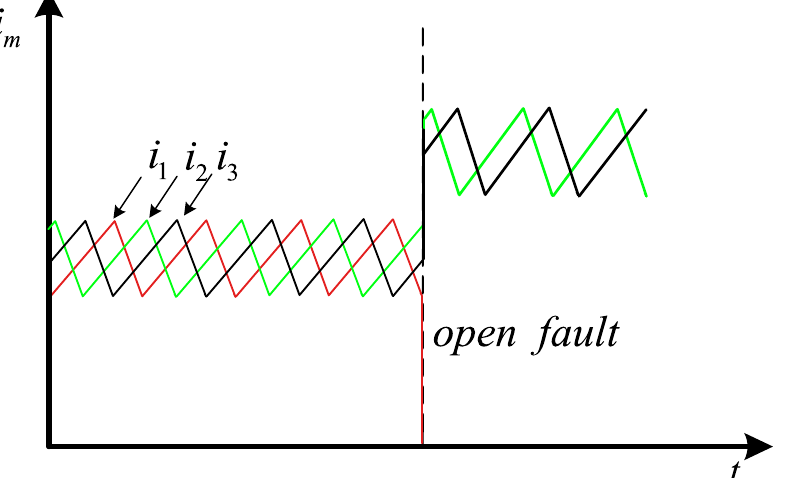
Figure 3. An inductor current after an